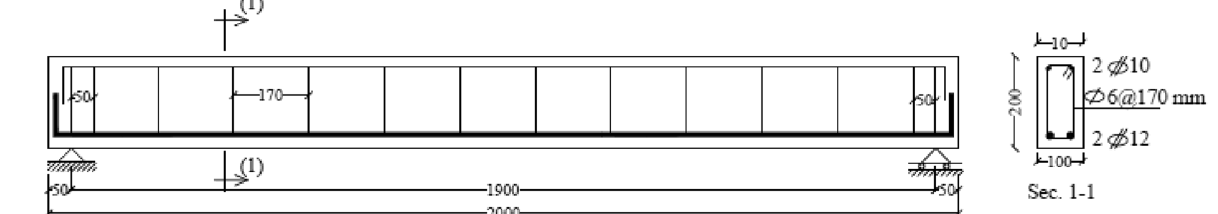
Fig. 7 Details of NWC beam (A1), dim in mm